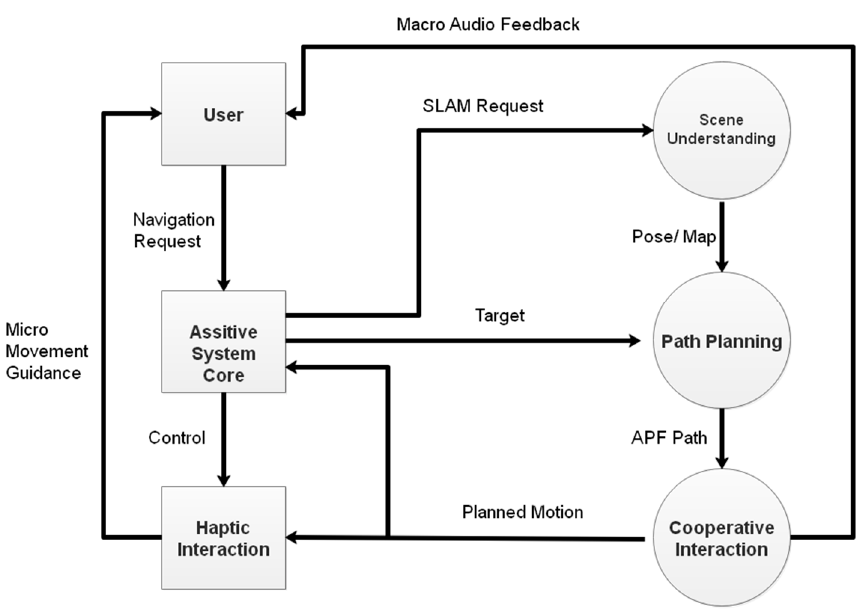
Figure 3. The working logic among the ANSVIP components: The physical components and soft components are shown on the left hand side and right hand side, respectively.